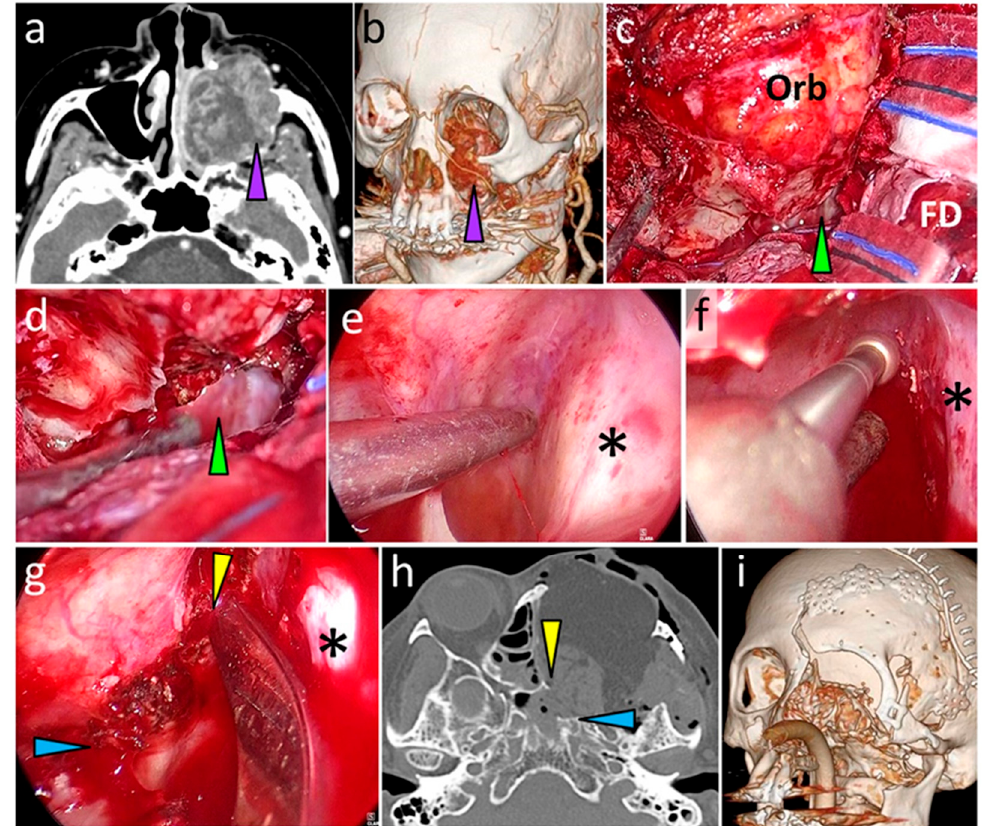
Figure 7. CT images and photographs of Case 1. ( a , b ) Preoperative axial CT and 3D-CT images showing maxillary sinus carcinoma invading the orbital apex and root of the pterygoid process (purple arrowheads). ( c , d ) Intraoperative exoscopic photographs showing the opened sphenoid sinus (green arrowheads). Orb: orbit. FD: frontal dura. ( e – g ) Intraoperative endoscopic photographs showing the sphenoid sinus lumen. *: midline intersphenoid septum. ( e ) Wide and clear visualization of the sphenoid sinus lumen. ( f , g ) The anterior wall (yellow arrowhead) and floor (blue arrowhead) of the sphenoid sinus are transected using a drill and curved chisel. ( h ) Postoperative axial CT scan showing the cut end of the anterior wall (yellow arrowhead) and floor (blue arrowhead) of the sphenoid sinus. ( i ) Postoperative 3D-CT image. CT, computed tomography; 3D, three-dimensional.